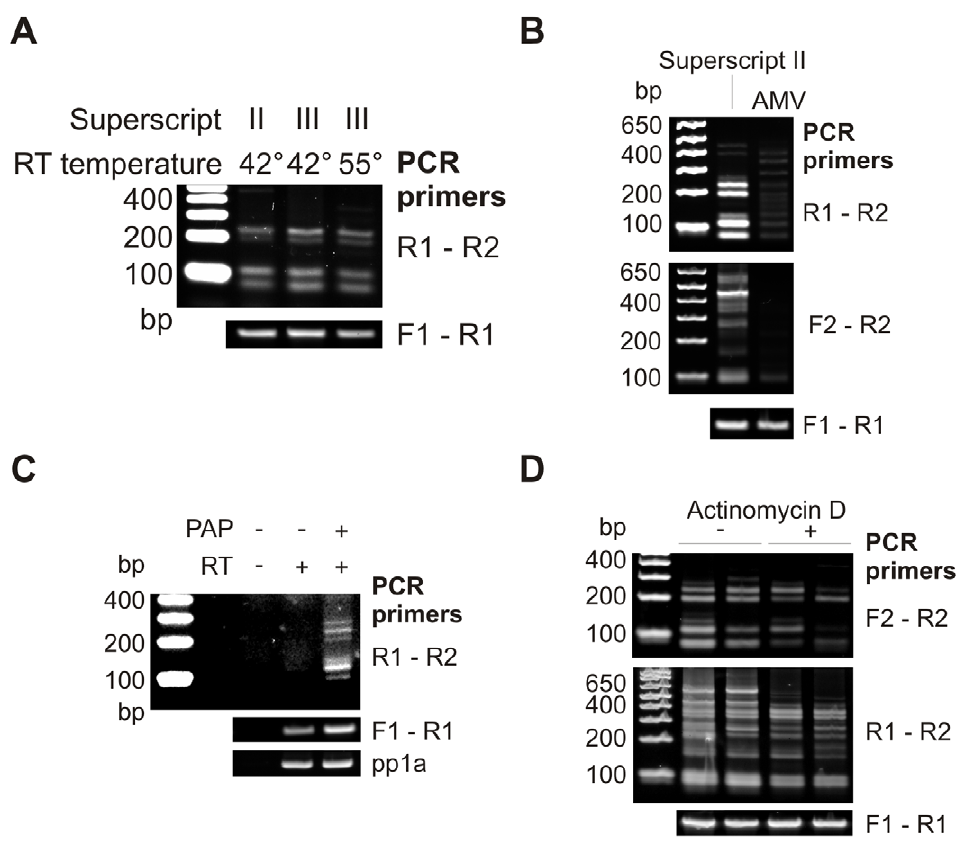
Figure 4. Generality of trans-splicing artifacts. A: PCR reactions for detecting sense-antisense fusion were performed on SPT7 substrate RNA reverse transcribed with Superscript II or III at the given temperatures. Upper panel 30 cycle PCR reactions; lower panel 25 cycles. B: PCR reactions for detecting sense-antisense fusion (upper panel) and exon shuffling (middle panel) were performed on SPT7 substrate RNA reverse transcribed with Superscript II or AMV. Upper panels 32 cycle PCR reactions; lower panel 25 cycles. C: RT-PCR using primers to detect sense-antisense fusions on poly(A) tailed RNA. Upper to lower panels show 32, 25 and 30 cycle PCRs. D: PCR reactions performed as in B using Superscript II, products from two RT reactions with and two RT reactions without 6 m g ml 2 1 Actinomycin D are shown.